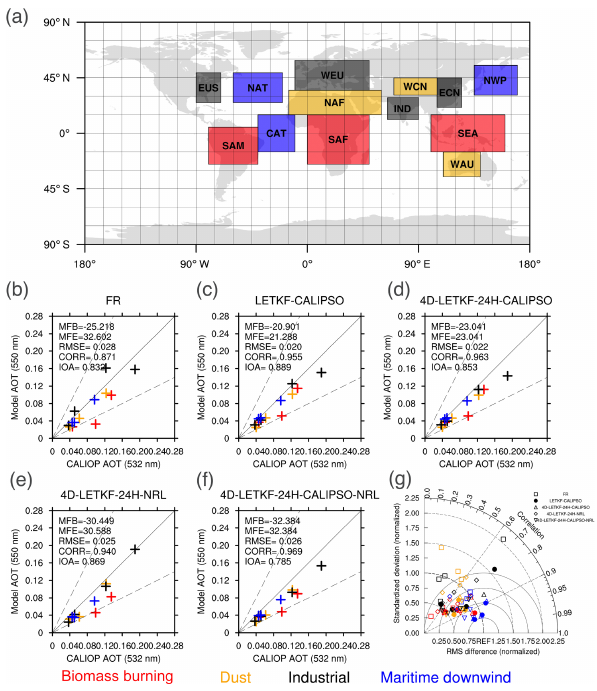
Figure 3. (a) The 13 domains selected for regional analysis in this study. The red, orange, black, and blue boxes indicate source regions of biomass burning smoke (SAM, SAF, and SEA), dust (NAF, WCN, and WAU), industrial pollution (IND, ECN, WEU, and EUS), and the outflow maritime regions downwind of major dust and industrial pollution sources (NWP, NAT, and CAT), respec- tively. Scatter plots of the simulated regionally averaged monthly mean column-integrated aerosol extinctions at 550nm versus the collocated CALIOP ones at 532nm over the 13 selected regions during November 2016 for the FR (b) , LETKF-CALIPSO (c) , 4D- LETKF-24H-CALIPSO (d) , 4D-LETKF-24H-NRL (e) , and 4D- LETKF-24H-CALIPSO-NRL (f) experiments. (g) A Taylor graph describing the column-integrated aerosol extinctions in the five ex- periments compared with the observed